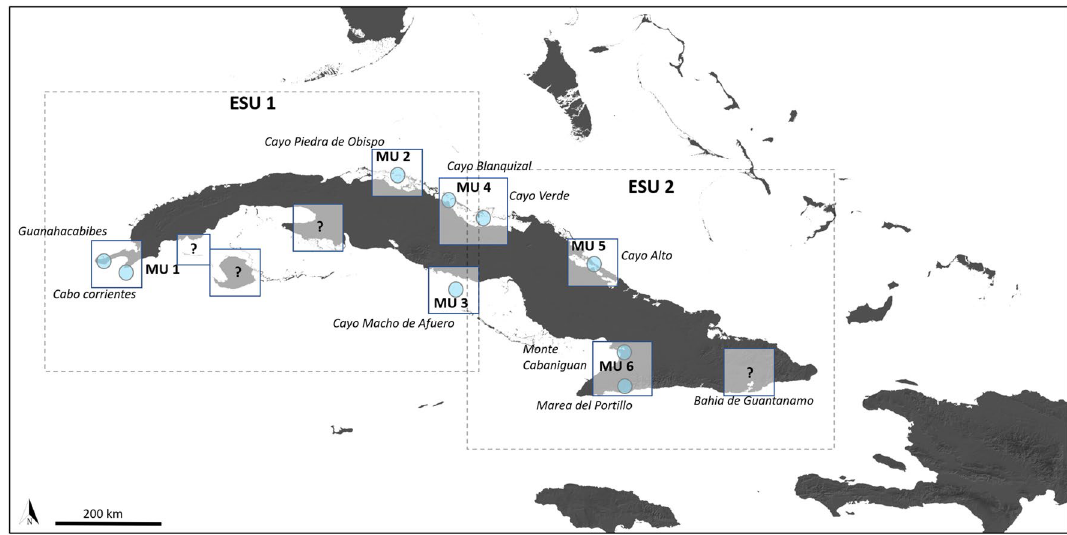
Figure 3. Map delineating Management Units (MUs) and Evolutionary Significant Units (ESUs). There are at least six distinct MUs on Cuba that correspond to our population genetic structure results. MUs marked with “?” represent known populations from other ecological studies which may or may not be genetically distinct MUs, but require genetic confirmation. The two ESUs correspond to the Western and Eastern groups based on mitochondrial DNA (Fig. 1). Map was drawn with QGIS v.3.10 (https